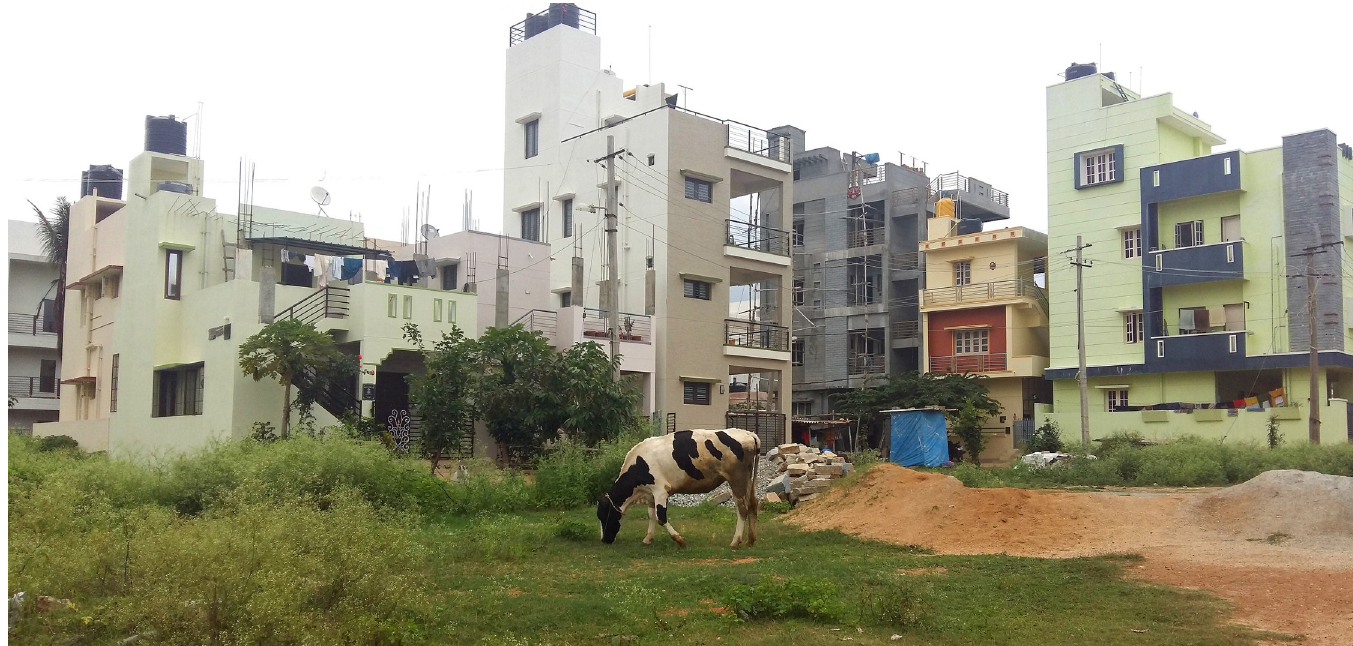
Fig 5. Pictures of dairy cattle in the streets and grazing on green public grounds. All pictures were taken in urban neighborhoods (SSI = 1 or 2).